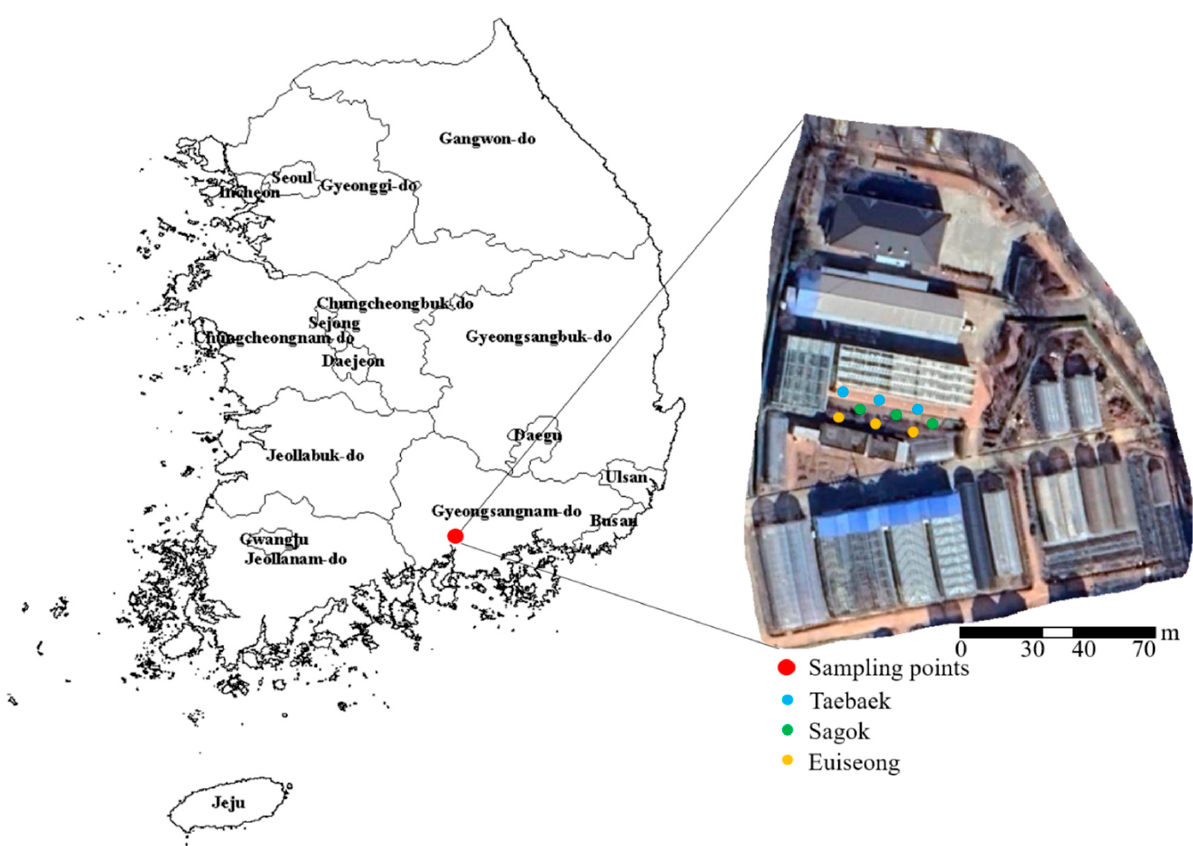
Figure 1. Location of the sampling site and cultivation area of the peony plants. Figure 7. Location of the sampling site and cultivation area of the peony